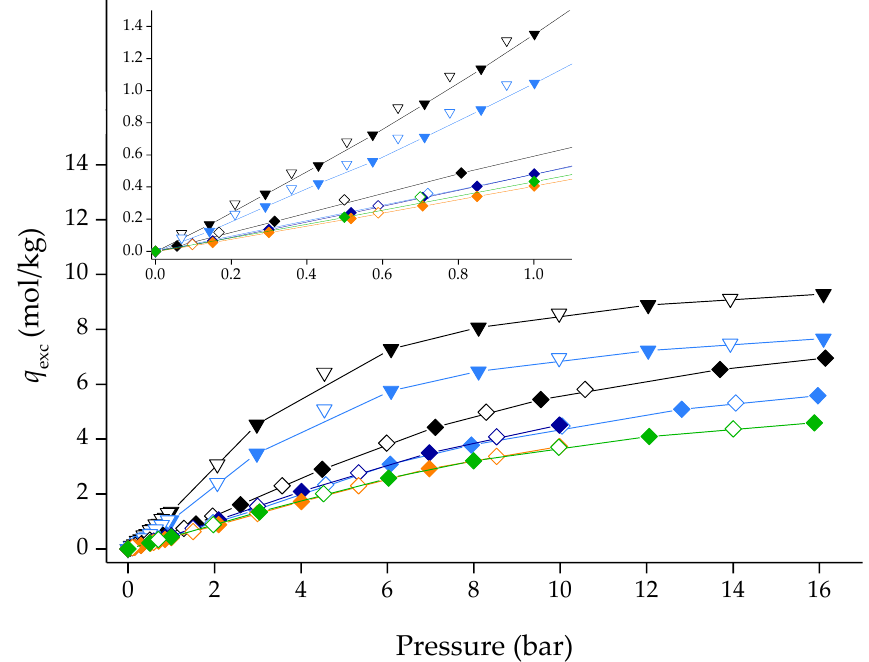
Figure 6. CO 2 adsorption/desorption equilibrium isotherms at 273 K (inverted triangles) and 303 K (diamonds) for ZIF-8 and [C n MIM][B(CN) 4 ]@ZIF-8 composites. Inset for the low-pressure region is highlighted. Closed and open symbols denote the adsorption and desorption data, respectively. Lines are guides to the eye. Symbols: (cid:72) / (cid:53) ZIF-8_273 K; (cid:72) / (cid:53) [C 6 MIM][B(CN) 4 ]@ZIF-8 (low)_273